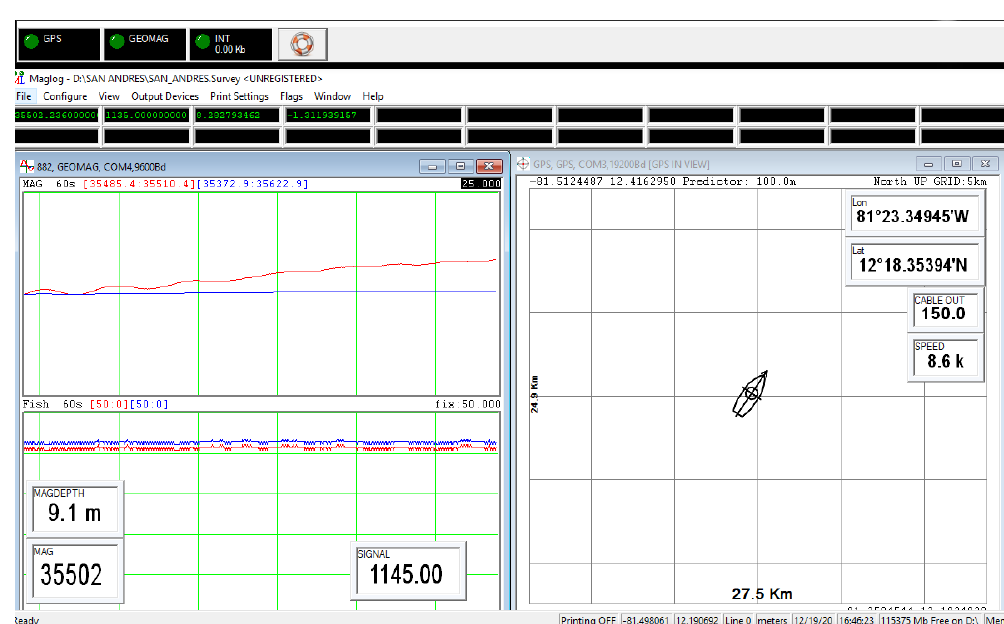
Figure 8. Visualization of geomagnetic information in MagLog software in real time.